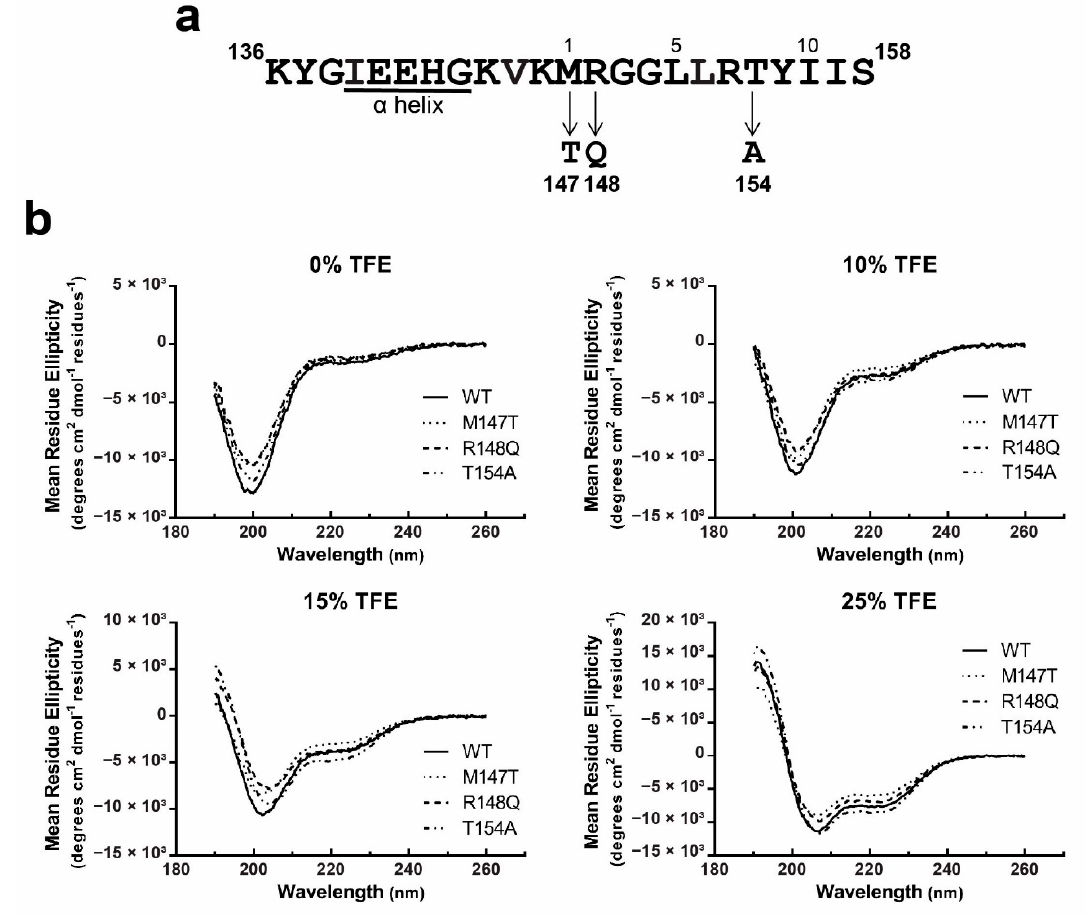
Figure 4. Structural analysis of the Cx43CL ODDD mutants M147T, R148Q, and T154A. ( a ) ODDD mutations localized in the predicted 1-5-10 CaM binding domain of Cx43CL are represented. ( b ) α -helical content of the Cx43CL 100-158 ODDD mutants M147T (dotted line), R148Q (dash line), and T154A (dotted and dash line) was estimated and compared with the Cx43CL 100-158 WT (black line) by collecting CD spectra in the presence of 0%, 10%, 15%, and 25%